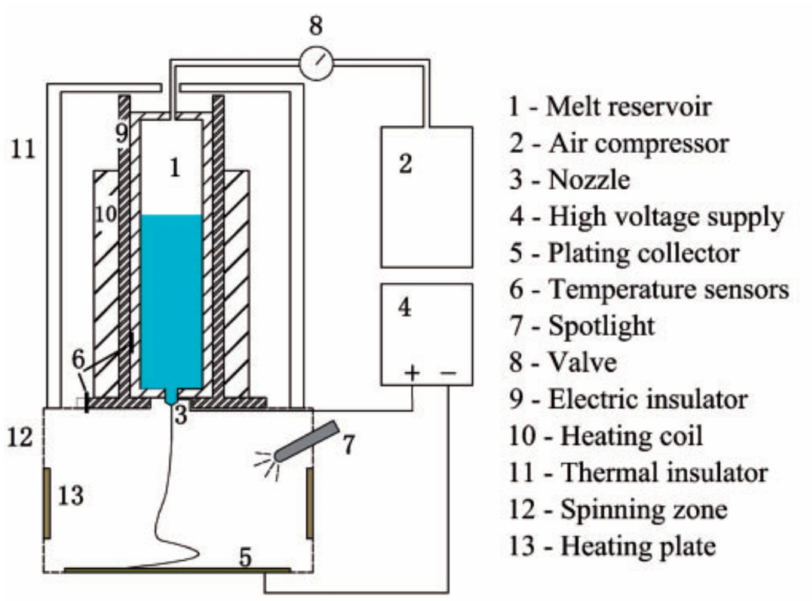
Figure 8. Schematic of melt-electrospinning. Reproduced under the terms and conditions of the liberal Creative Commons Attribution 4.0 International (CC BY) license from [87]. Published by